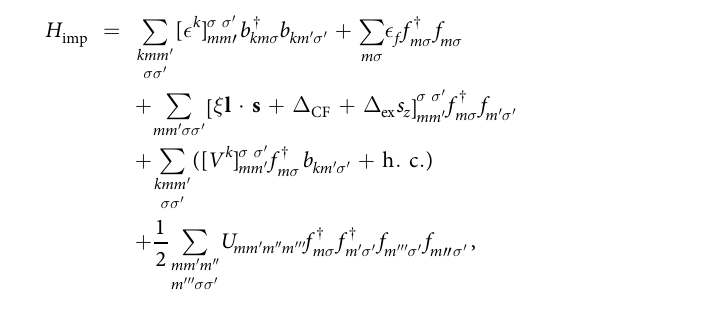
Figure 2. Scheme of quantum many-body levels of the lowest J f = 8.00 multiplet obtained in Eq. (1) with the Δ CF parameters for spin-polarized calculations and polarized calculations ( B